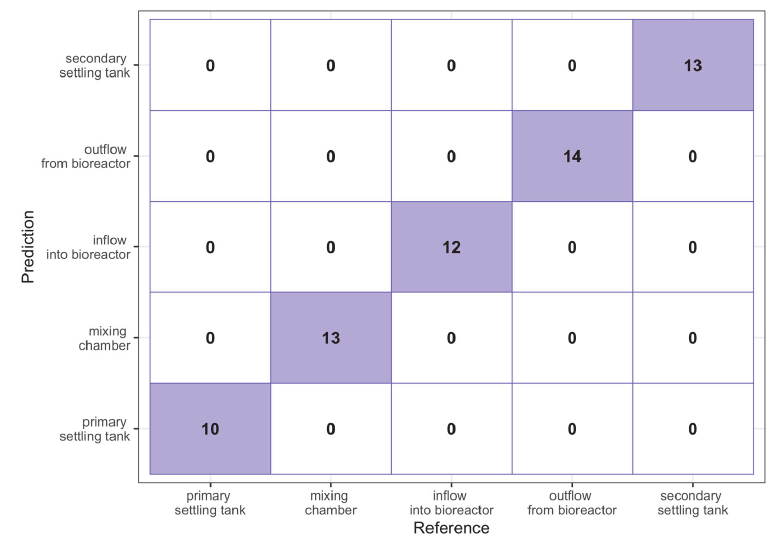
Figure 6. Contingency matrix for random forest model on the test sample.